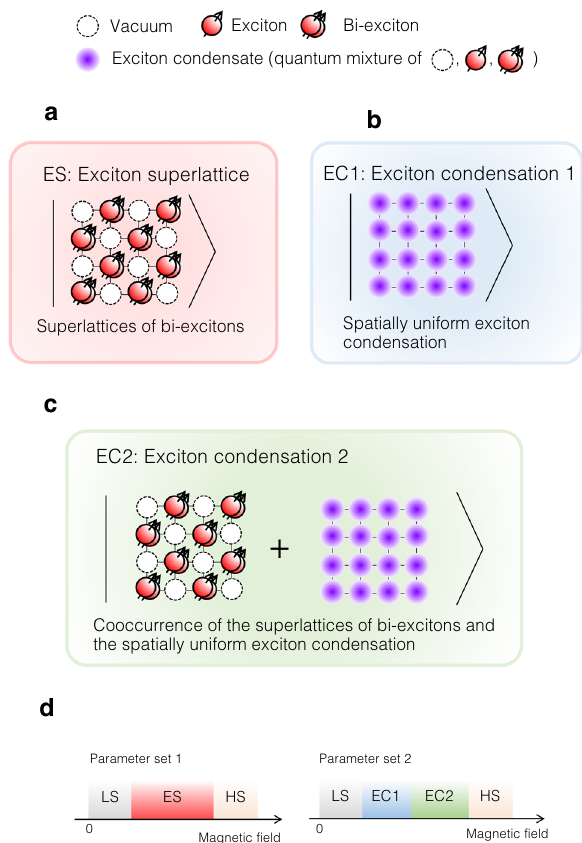
Fig. 4 | Schematic illustrations of calculated excitonic phases. a Exciton superlattice (ES), where exciton and vacuum form a superlattice. b Exciton con- densation 1 (EC1), where Bose-Einstein condensation of excitons occur spatially uniformly. c Exciton condensation 2 (EC2), where Bose-Einstein condensation of excitons occur with a translational symmetry breaking. d Magnetic fi eld depen- denceofthemean- fi eldphaseswiththeassumptionof distinctparametersets.See Supplementary Note 2 for the details of the